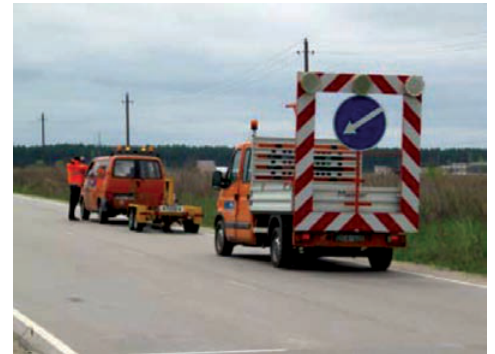
Fig. 2. Research of pavement structures in the experimental